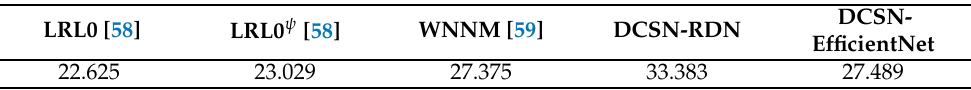
Figure 11. Computational time (seconds) for different upsampling factors [ 1.1,1.2,...,3.9,4.0 ] using different methods on the Art depth map. Note that the results for the method of Song et al. for noninteger scale factors were obtained by applying bicubic interpolation to the upscaled results of the nearest integer scale factor. Table 3. Average PSNR of different methods on the missing depth value dataset [58] for the denoising task (a higher PSNR is better). LRL0 denotes Low Rank Matrix Completion and LRL0 ψ denotes Low Rank Matrix Completion with low gradient regularization